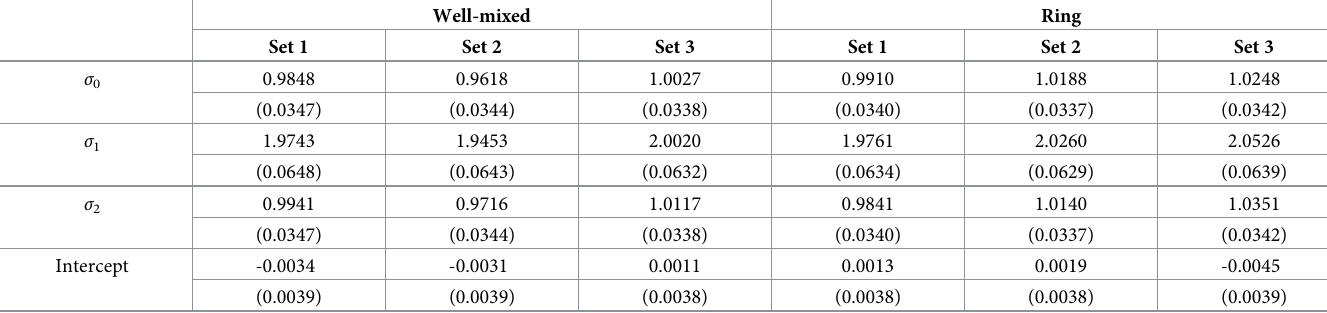
Table 3. Estimating the coefficients σ k s by simulation. We establish three sets of individualised aspirations based on the uniform distribution in [0, 1] (see S2 File for details). For three-player games with b 0 = b 1 = b 2 = 0, the estimated coefficients σ 0 , σ 1 , σ 2 are obtained by linear regression model in the form of σ 0 a 0 + σ 1 a 1 + σ 2 a 2 + Intercept. For rings, the regression coefficients σ 0 , σ 1 , σ 2 and Intercept are close to 1,2,1 and 0, which agrees perfectly with theoretical calculations Eq (10). In addition, it holds for all the three sets of aspirations, validating the theorem. For well-mixed populations, the d coefficients still hold, consistent with [34]. Thus the coefficients are robust to the heterogeneity in aspiration for both ring and well-mixed population. The confidence interval for the corresponding estimated coefficients (EC) are [EC-ME, EC+ME], where ME in the parentheses is calculated with confidence level 95%. Please refer to the Methods to see the details of the simulation. Population size N = 100, selection intensity β = 5 × 10 −2 . More details of the simulation are found in S1